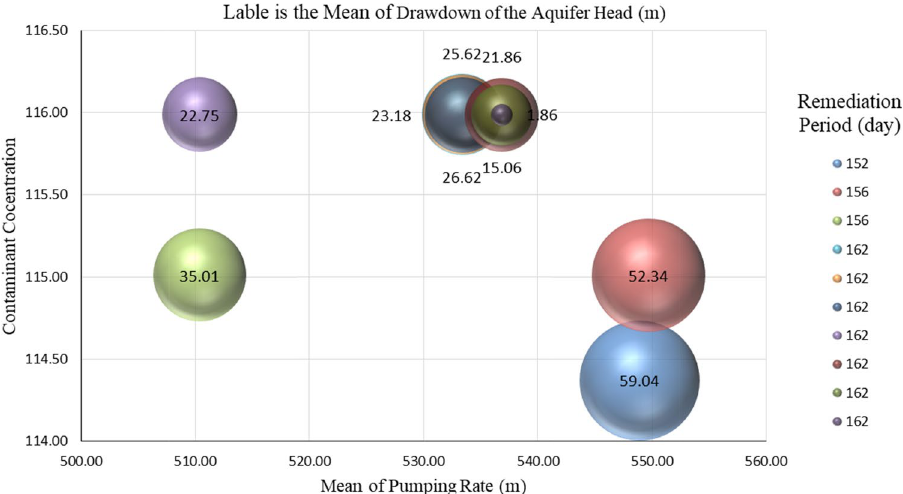
Fig. 18 Pareto front of